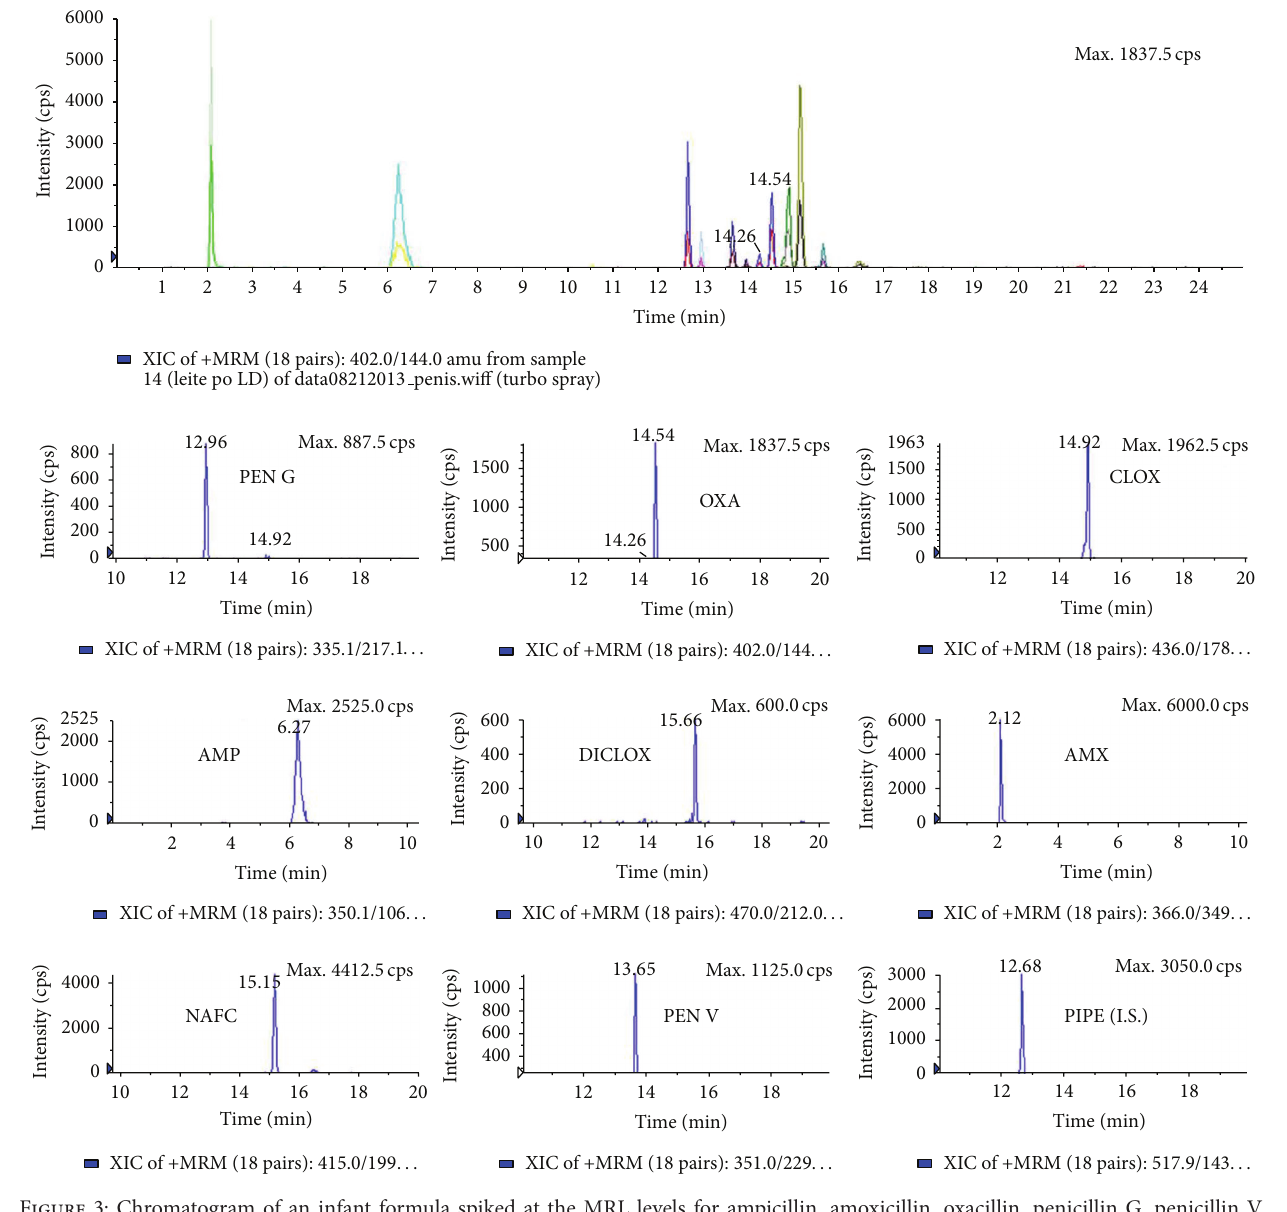
Figure 3: Chromatogram of an infant formula spiked at the MRL levels for ampicillin, amoxicillin, oxacillin, penicillin G, penicillin V, cloxacillin, dicloxacillin, and nafcillin (internal standard: